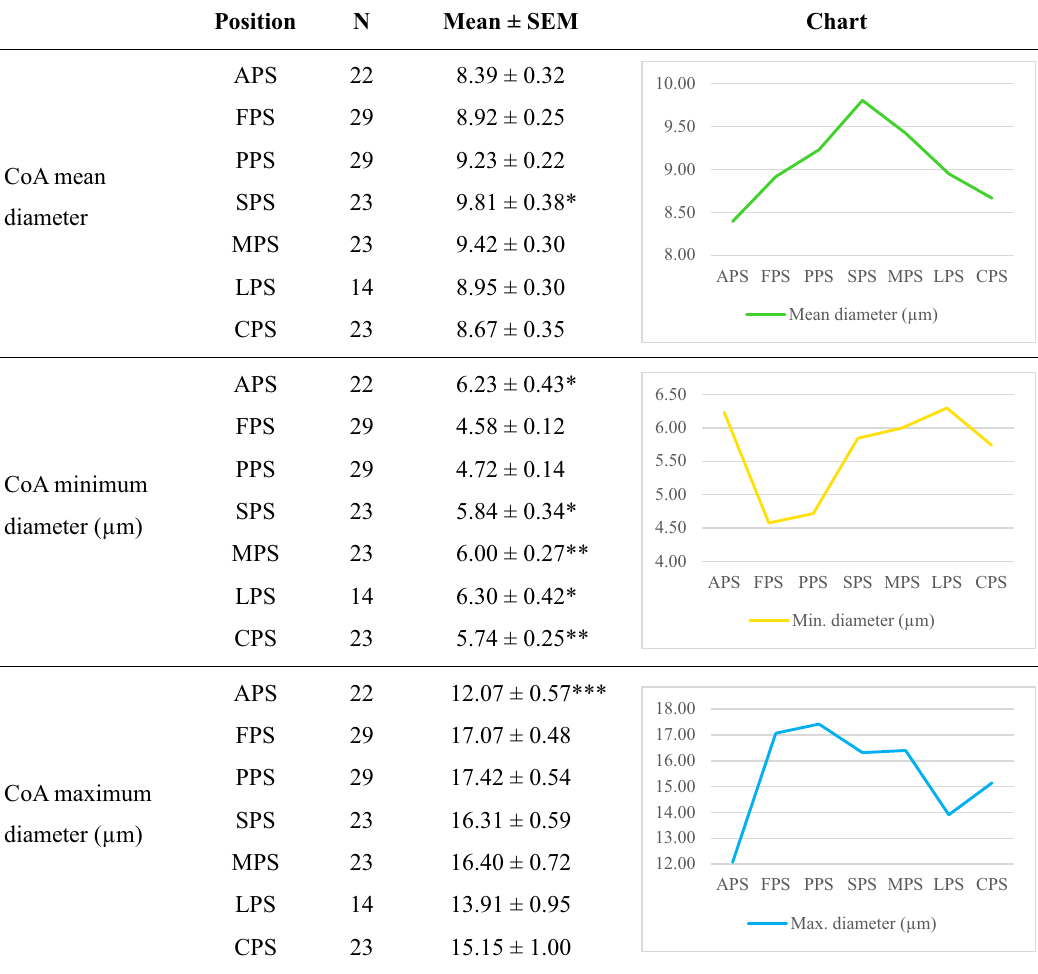
Table 2. CoA sizes in seven pial surface regions. CoA at fimbria pial surface (FPS) region display the smallest minimum diameter among all seven pial surface regions, and there is a trend towards a larger size when progressing laterally from the FPS to the CPS; while the maximum diameter show a decreasing trend. One-way ANOVAs with post hoc test for multiple comparisons were performed: FPS compared to APS, PPS, SPS, MPS, LPS and CPS. LSD post hoc test was used with equal variances, while Games-Howell were used with unequal variances. The listed p values are after adjustment for Type 1 error with FDR. APS alveus pial surface, FPS fimbria pial surface, PPS prosubiculum pial surface, SPS subiculum pial surface, MPS medial entorhinal cortex pial surface, LPS lateral entorhinal cortex pial surface, CPS collateral sulcus pial surface. * p < 0.05, ** p < 0.01, *** p <